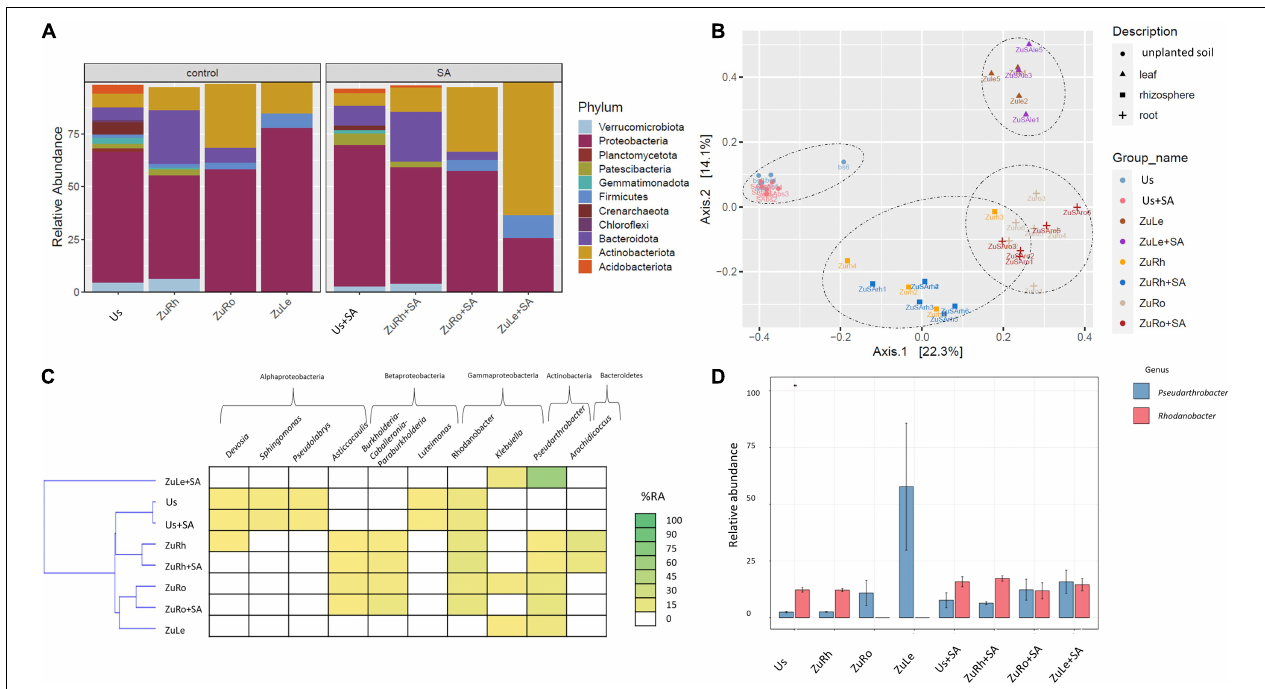
FIGURE 2 | Bacterial communities structure based on 16S rRNA gene sequence for SA-amended variants in comparison to untreated variants: (A) relative abundances (%) of the bacterial community at the phylum level; (B) PcoA ordination plots of the results based on the Bray–Curtis distances of the classified 16S rRNA gene sequences; (C) Heat map of top 10 genera in each treatment; (D) Relative abundance (%) of Pseudarthrobacter and Rhodanobacter in the different treatments. Variants: Us, unplanted soil; ZuRh, zucchini rhizosphere soil; ZuRo, zucchini root; ZuLe, zucchini leaves; Us + SA, unplanted soil treated with SA; ZuRh + SA, zucchini rhizosphere soil treated with SA; ZuRo + SA, zucchini root from soil treated with SA; ZuLe + SA, zucchini leaves from soil treated with